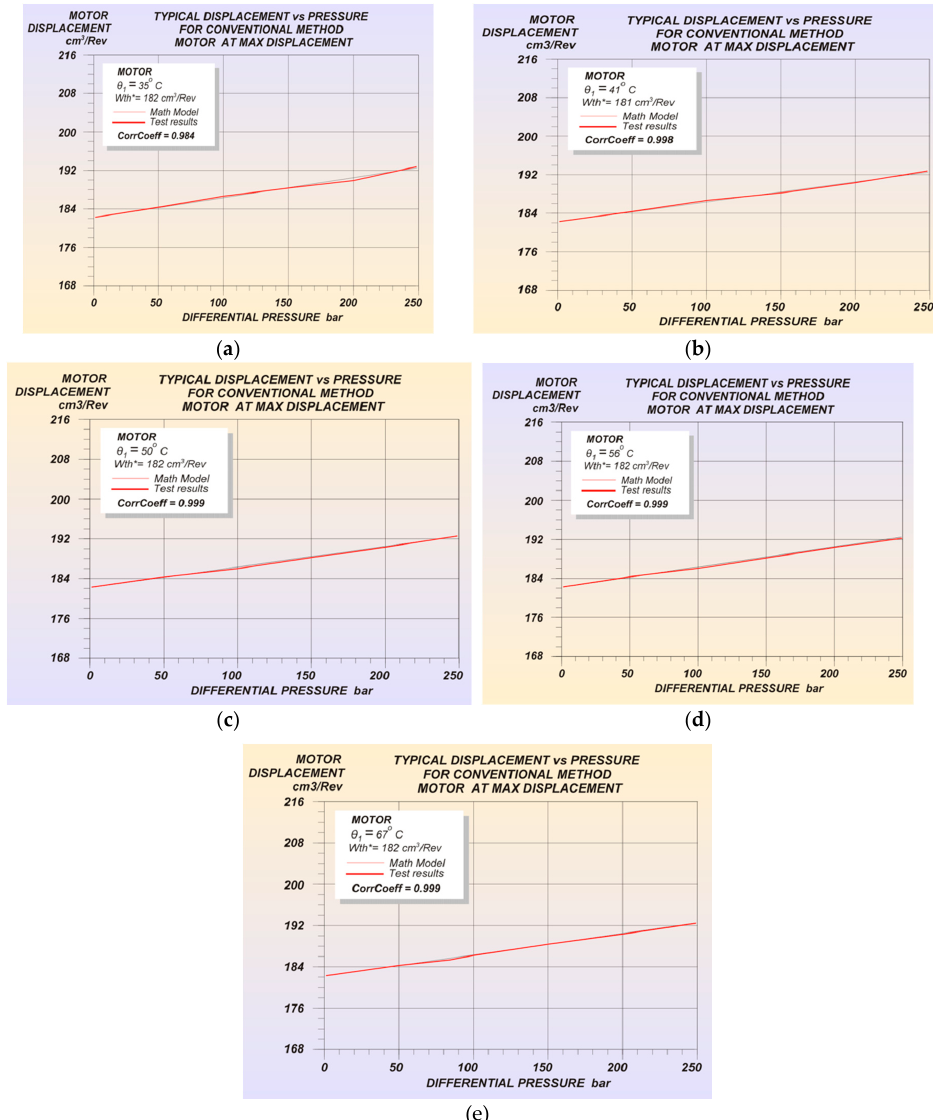
Figure 9. Determination of theoretical displacement, 𝑊 𝑡ℎ∗ , and axial piston motor at ( a ) 35 ° C, ( b ) 41 ° C, ( c ) 50 ° C, ( d ) 56 ° C, and ( e ) 67 ° C.